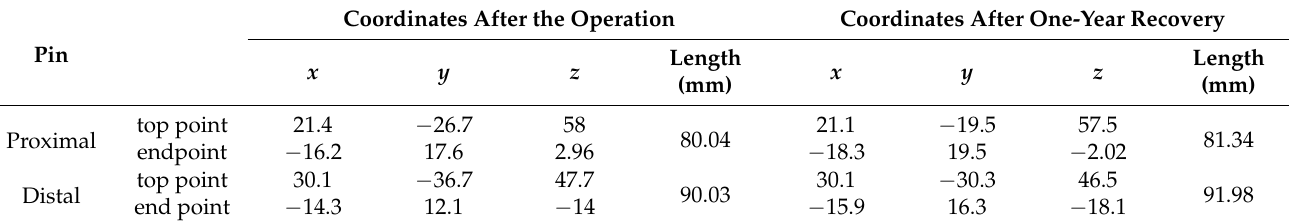
Table 8. Results measured by traditional